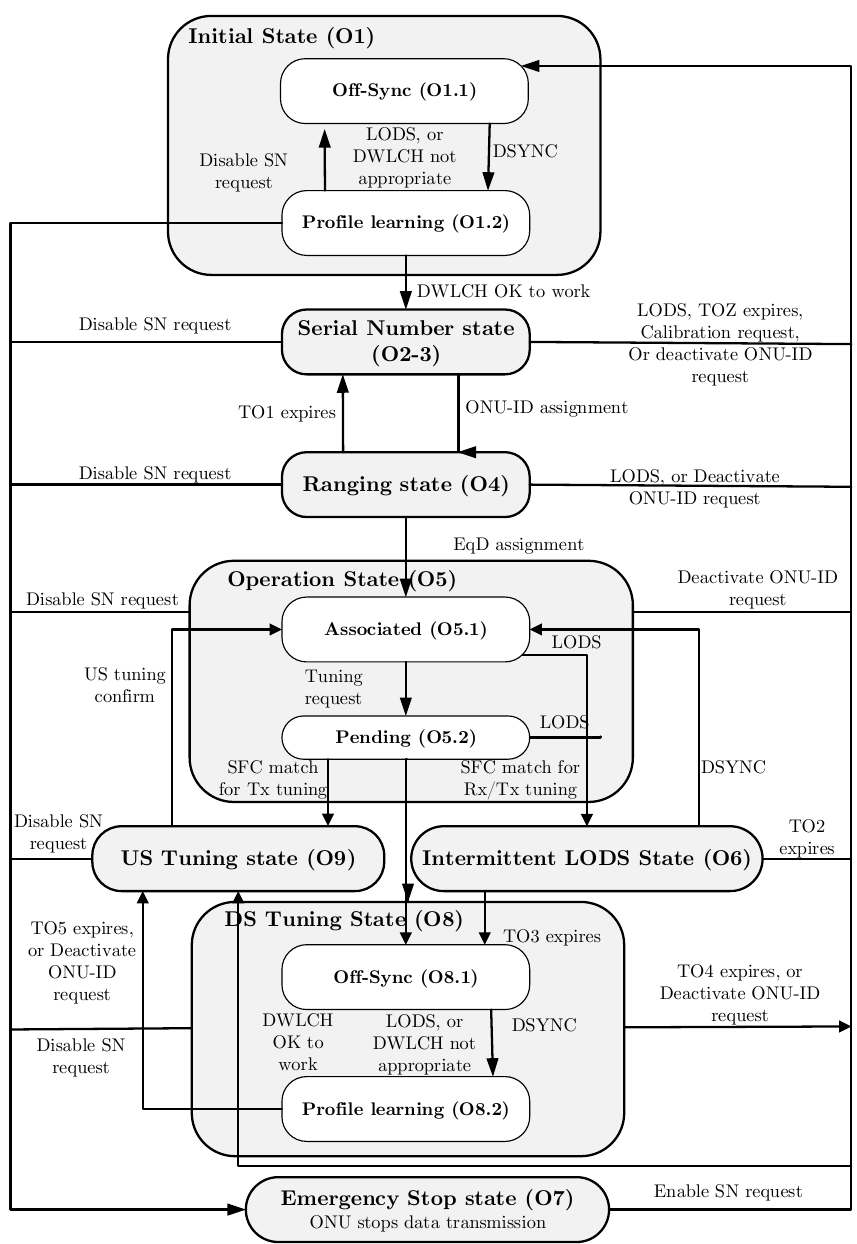
Figure 2. State diagram of ONU unit for NG-PON2